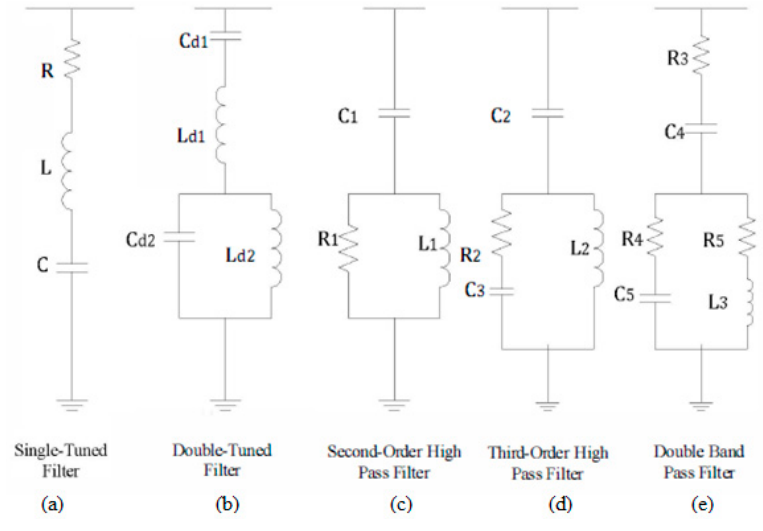
Figure 1. Several arrangements of passive filters [17].